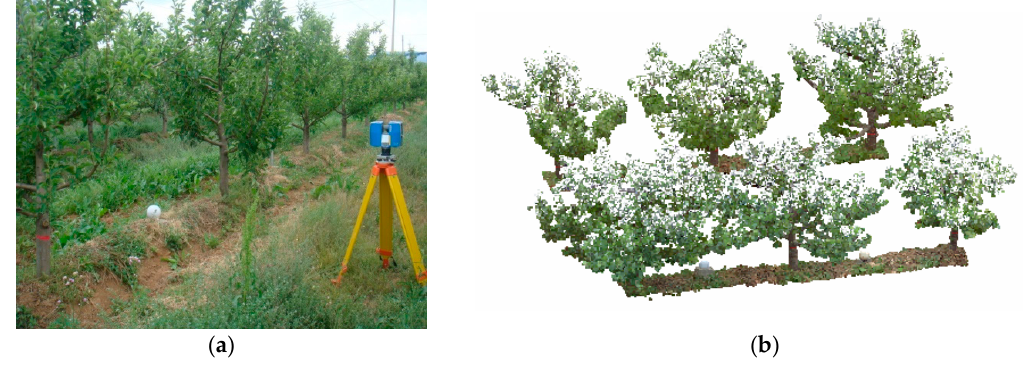
Figure 4. Laser scanner used in the apple orchard and acquired 3D data of apple trees. ( a ) Laser scanner used in the apple orchard; ( b ) 3D data of apple trees.